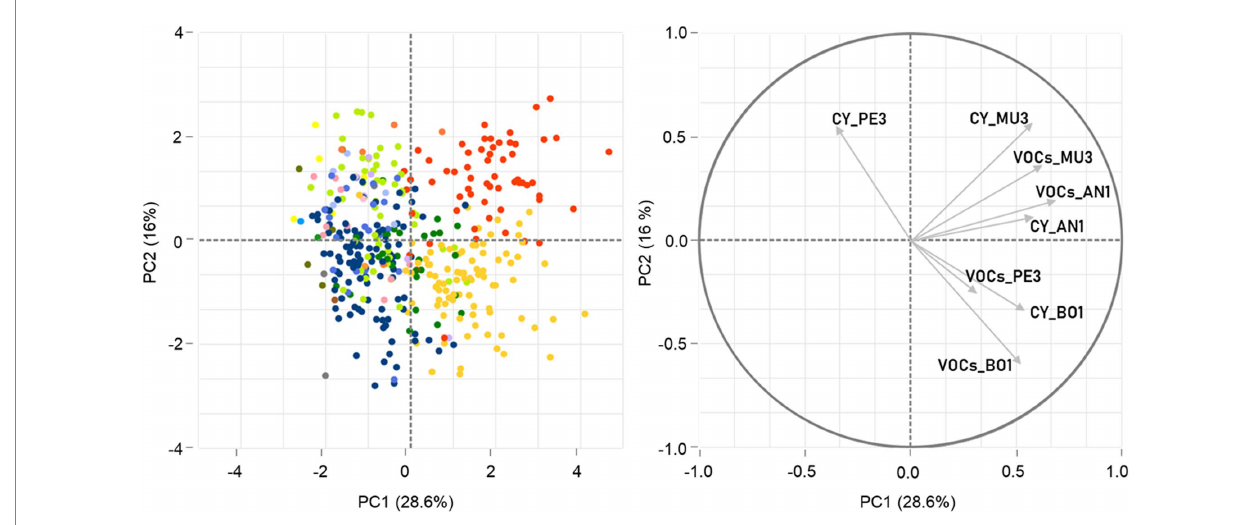
FIGURE 2 Principal component analysis (PCA) of yeast antagonistic activity against the four mold targets. The spatial representation of the 397 yeast strains according to the two first principal components (PC1 and PC2) is built on their inhibitory activity against Aspergillus niger AN1, Botrytis cinerea BO1, Mucor sp. MU3 and Penicillium sp. PE3, mediated by diffusible (CY) and volatile compounds (VOCs) and determined by IRG. The data points, corresponding to the yeast strains tested, were colored by genera affiliation following the color scheme used in Figure 1.